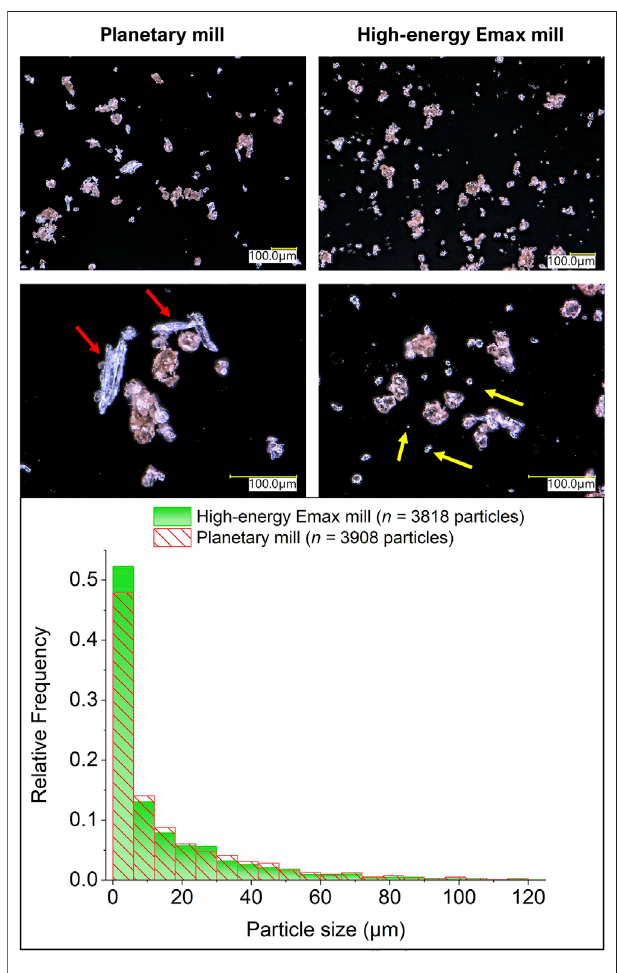
FIGURE 4 | Digital optical micrographs and size particle distribution for H 2 SO 4 -impregnated beechwood processed at low energy dose (3.3 kJ mol − 1 ) in different mills. The arrows in yellow color indicate small particles (1 – 6 μ m) typically formed by the H 2 SO 4 -impregnated beechwood processed in a high-energy Emax mill. The arrows in red color indicate substantial residual particles (50 – 125 μ m) typically obtained by processing H 2 SO 4 -impregnated beechwood in the planetary mill at a low energy